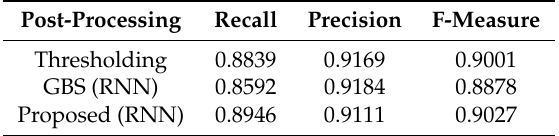
Table 2. Transcription results on the software piano “StbgTGd2”. GBS, global beam